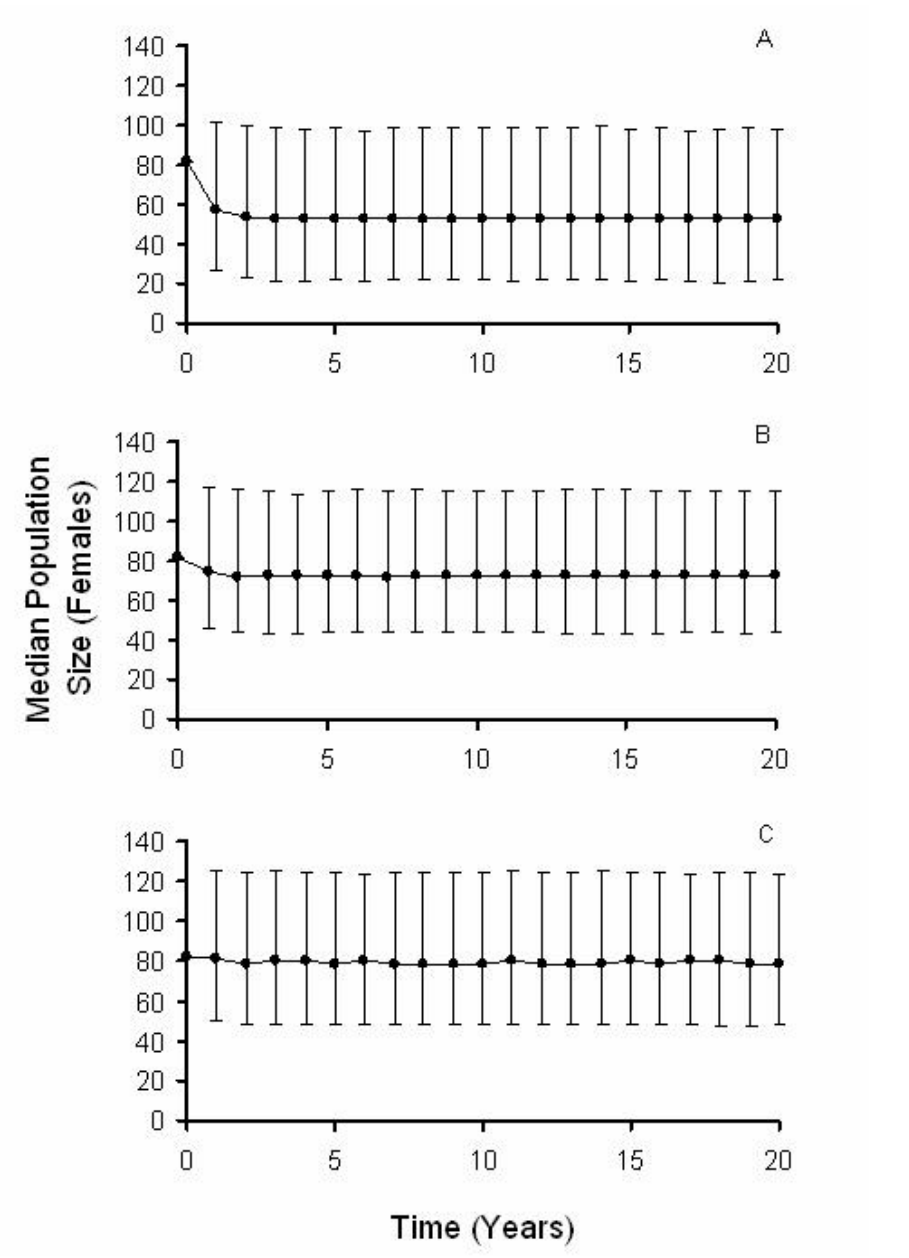
Fig. 1. Predicted population size of female B. parvus at Mount Higginbotham for 20 years in the presence of the road (A), after construction of tunnels to mitigate the barrier effect of a road (B), and in the absence of the road (C). The predictions are based on mean parameter estimates and show the median population size and the 95% prediction interval based on environmental and demographic